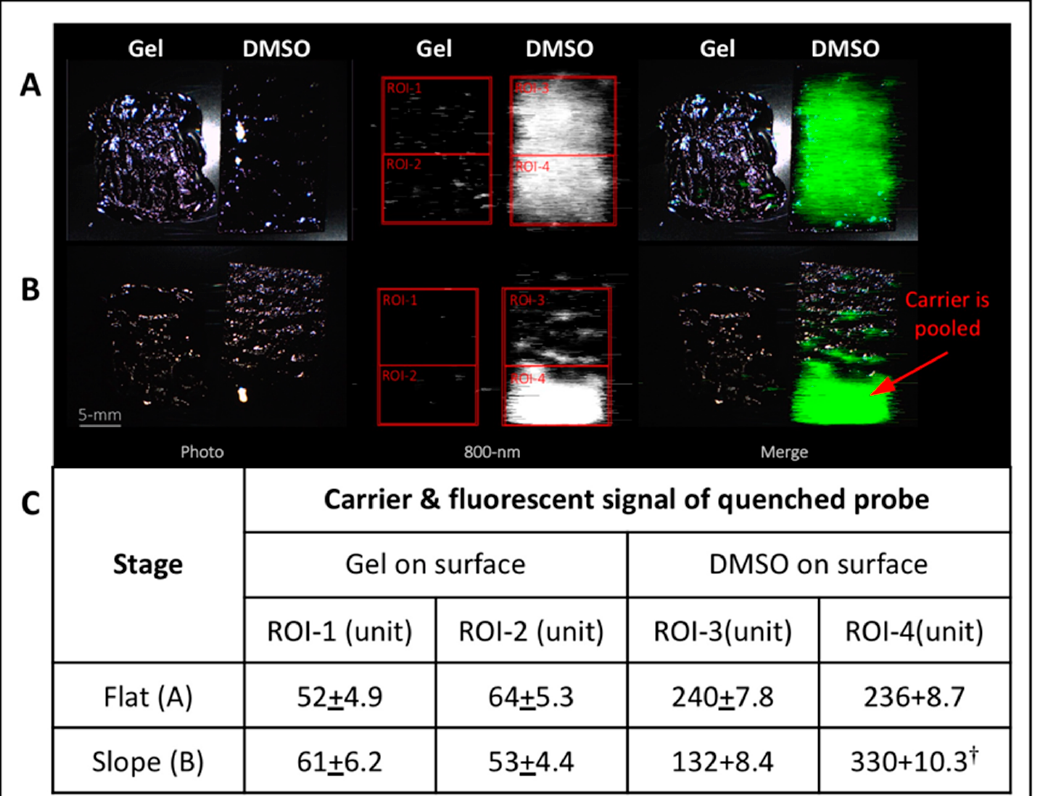
Figure 3. Thermo-sensitive Pluronic F-127 hydro-gel#30 possesses better carrier characteristics for “no drip” topical applications of AKRO-QC-ICG imaging probe under force of gravity. Analysis of behavior of carriers of the AKRO-QC-ICG imaging probe. Both AKRO-QC-ICG (final 5 μ M) dissolved in 50 μ L of Pluronic F-127 hydro-gel#30 and a paper applicator impregnated with AKRO- QC-ICG (final 5 μ M in 50 μ L of DMSO) were topically applied to a plastic surface that was pre- heated at 37 °C. ( A )—Distribution of the AKRO-QC-ICG in the carriers on the flat surface. ( B )— Scale bar 5 mm. ( C )—Analysis of the levels of auto-fluorescence of AKRO-QC-ICG at the upper and bottom quadrant of the applied carrier in the regions of interest (ROIs). Data were normalized to